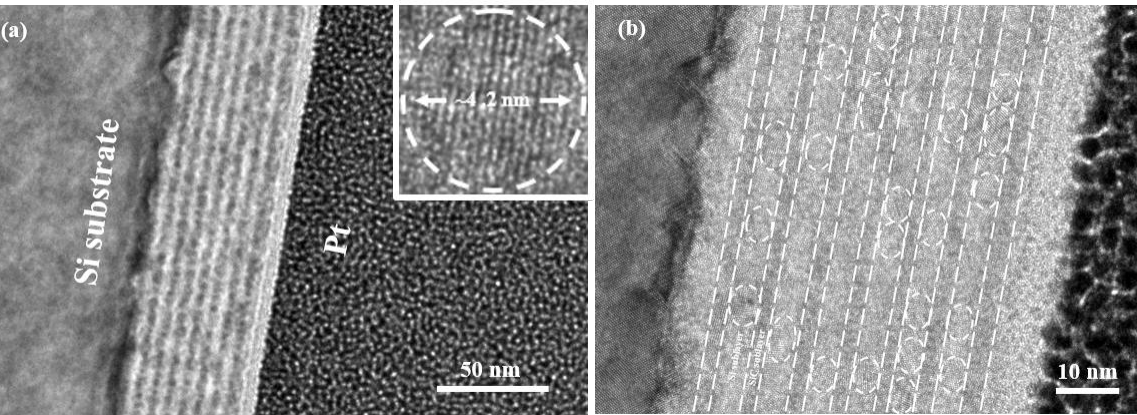
Figure 1. Cross-sectional TEM images of Si NCs/SiC multilayers at 50 nm scale ( a ) and 10 nm scale ( b ). Inset is the high-resolution TEM images of a single Si NC. scale ( b ). Inset is the high-resolution TEM images of a single Si